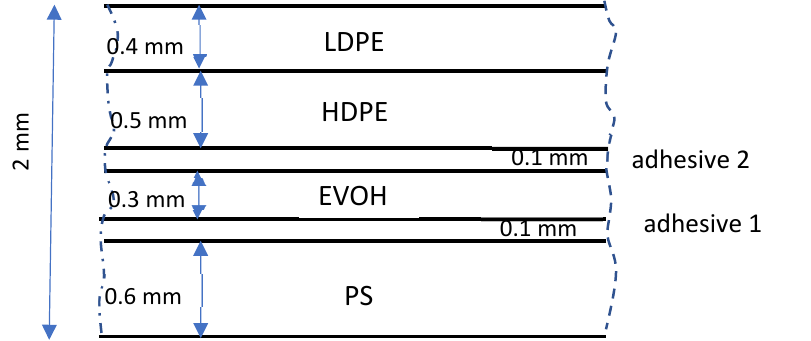
Figure 14. Typical multilayer coextruded product.